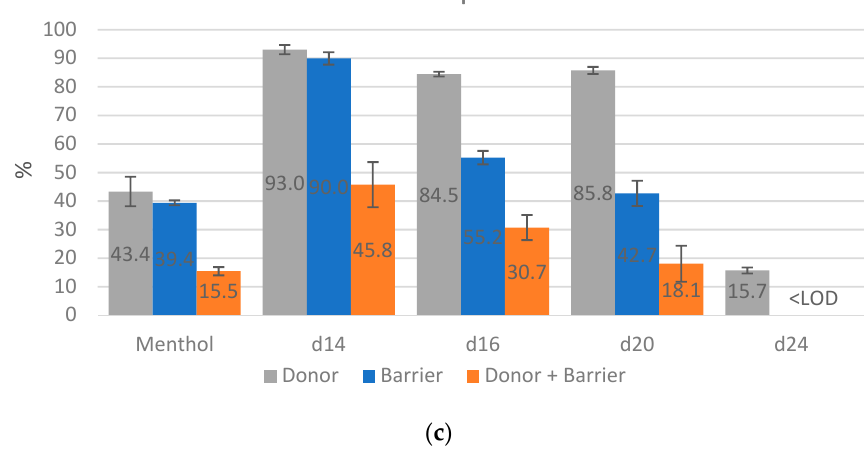
Figure 3. Permeation through samples ( a ) 40 µ m LLDPE film, ( b ) 70 µ m LLDPE film, and ( c ) 50 µ m PP Figure 3. permeation through samples ( a ) 40 µm LLDPE film, ( b ) 70 µm LLDPE film, and ( c ) 50 µm film. n = PP film. n = 3.